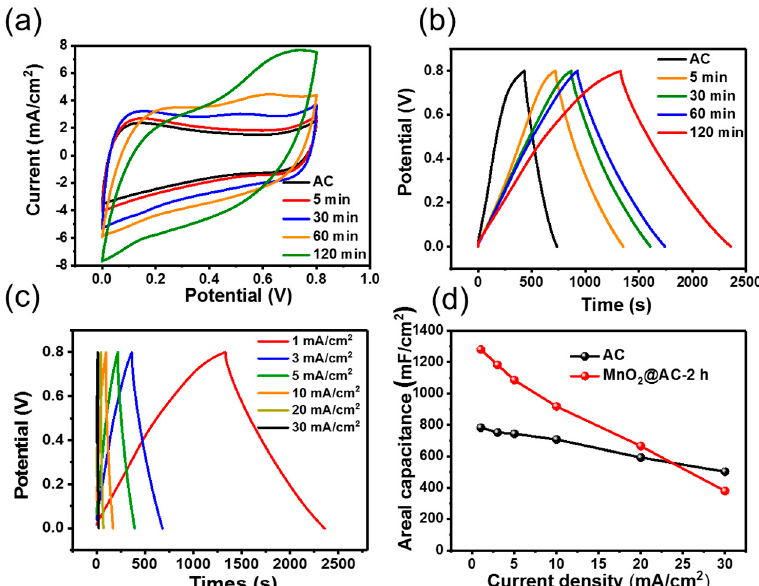
Figure 4. Electrochemical performance of the MnO 2 @AC and AC electrodes: ( a ) CV curves of MnO 2 @AC with different deposition times at a scan rate of 5 mV s − 1 . ( b ) Charge–discharge profiles of MnO 2 @AC with different deposition times at a current density of 1mA/cm 2 . ( c ) Charge–discharge profiles of MnO 2 @AC-2 h at different current densities. ( d ) The area-specific capacitance of MnO 2 @AC.